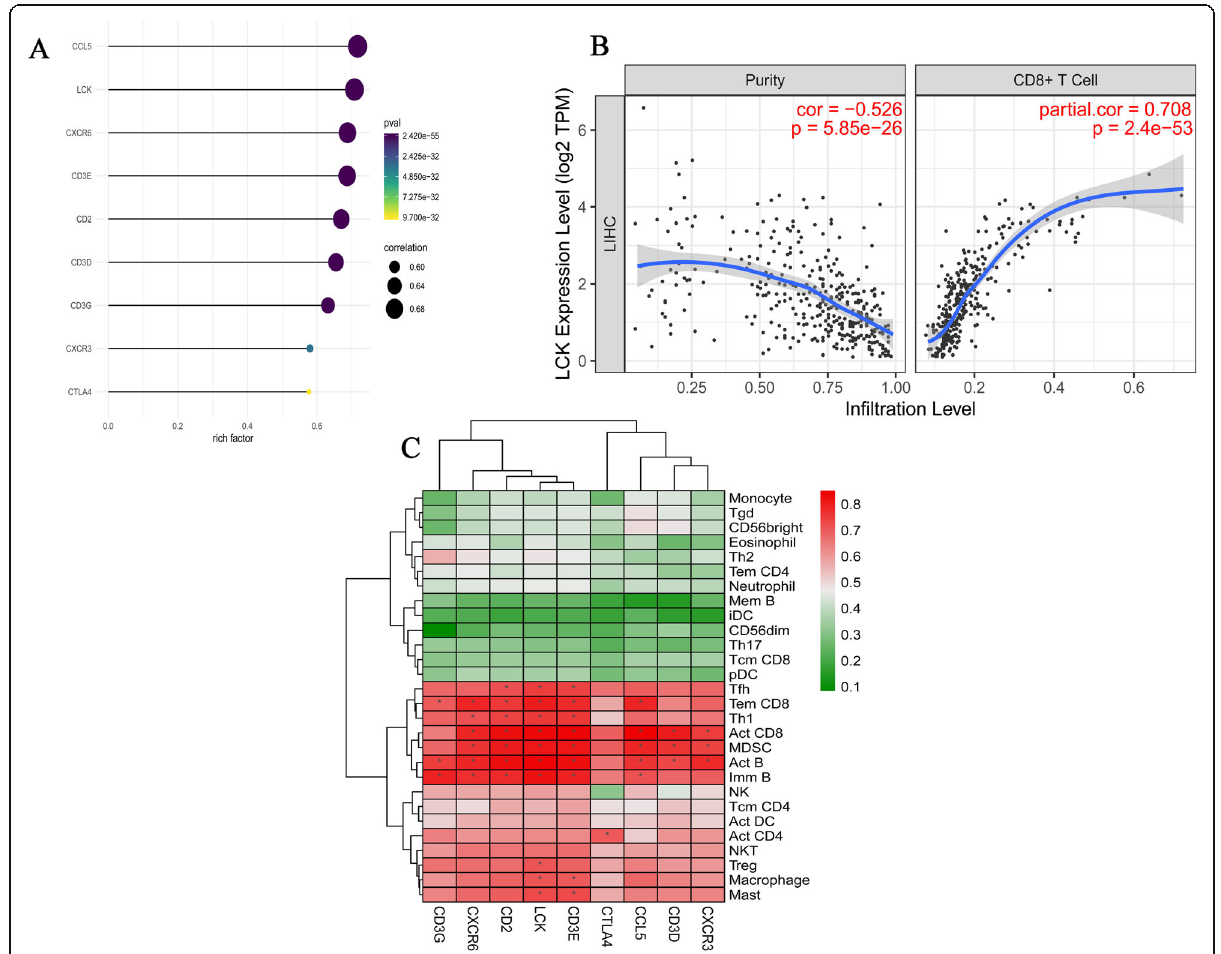
Fig. 5 Validation of hub genes. A Association between the expression levels of 9 hub genes and CD8 + T cell infiltration levels in TIMER database. B Association between LCK expression and CD8 + T cell infiltration levels in TIMER database. C Association between the expression levels of the 9 hub genes and tumor-infiltrating immune cells (TIICs) in TISIDB database. Red indicates a high correlation and green indicates a low correlation. TIMER: Tumor Immune Estimation